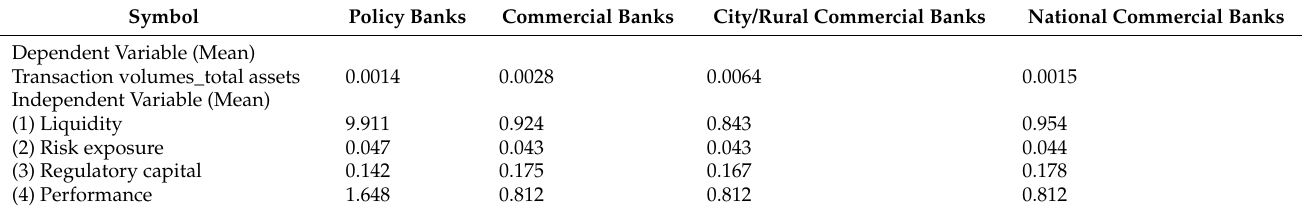
Table 5. Bank-specific determinant variable comparison (post-2017Q4).